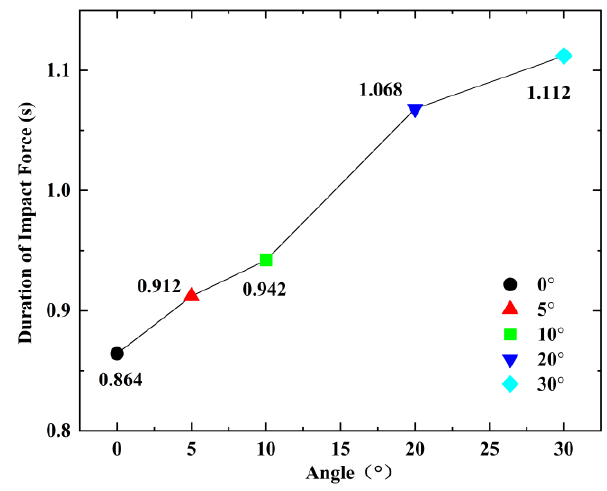
Figure 17. Collision durations at different impact angles.